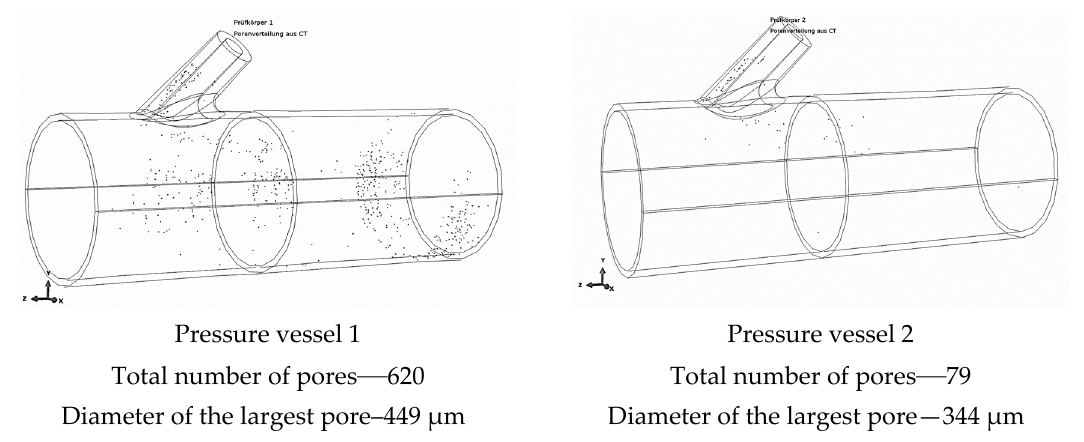
Figure 3. Evaluation of pore distribution and size in the two additively manufactured model pressure vessels [20].